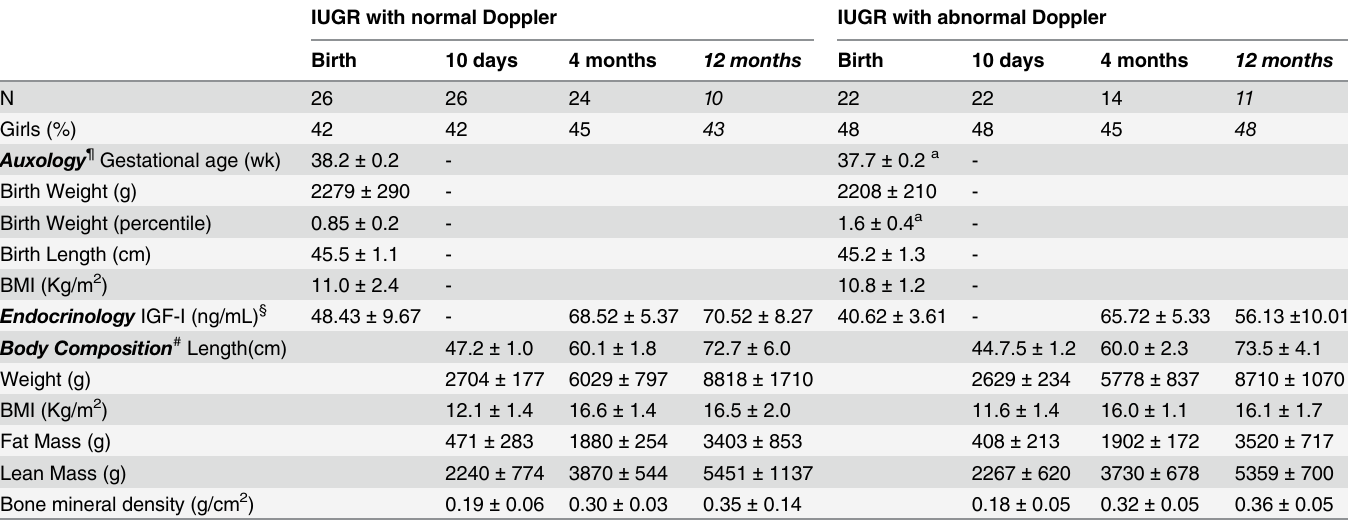
Table 1. Anthrompometry and body composition of IUGR with normal and abnormal Doppler. IUGR with normal Doppler IUGR with abnormal